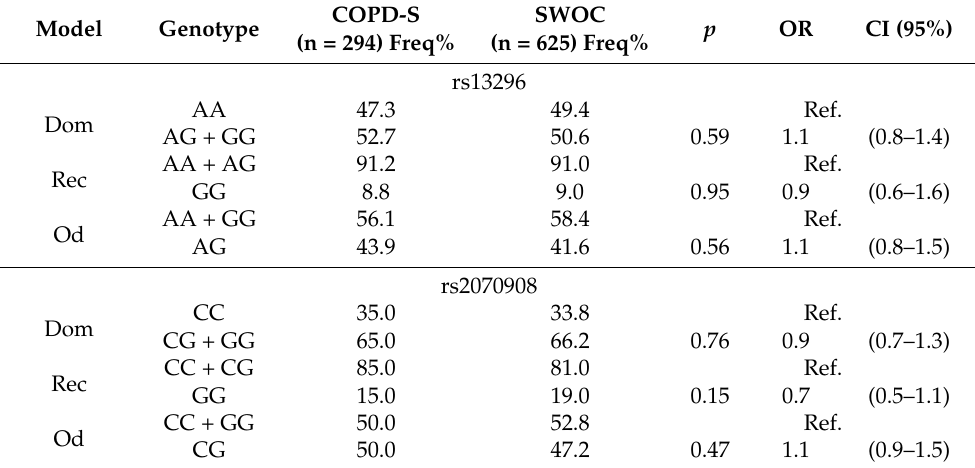
Table 6. Analysis by models in the tobacco smoking